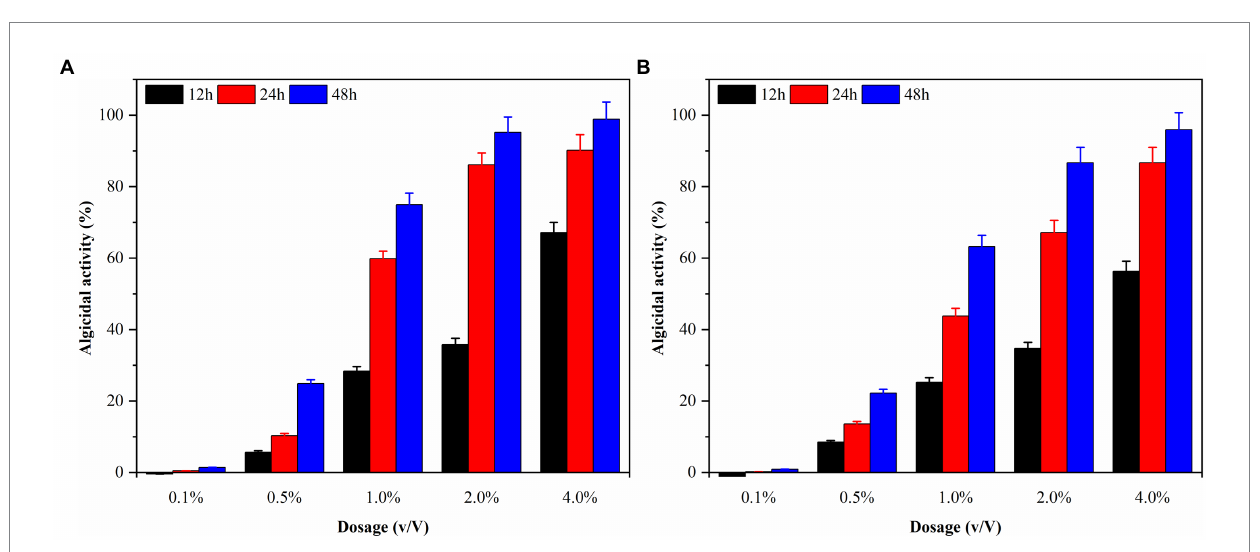
FIGURE 5 The algicidal activity of G. catenatum (A) and K. mikimotoi (B) with different dosage of sterile fermentation